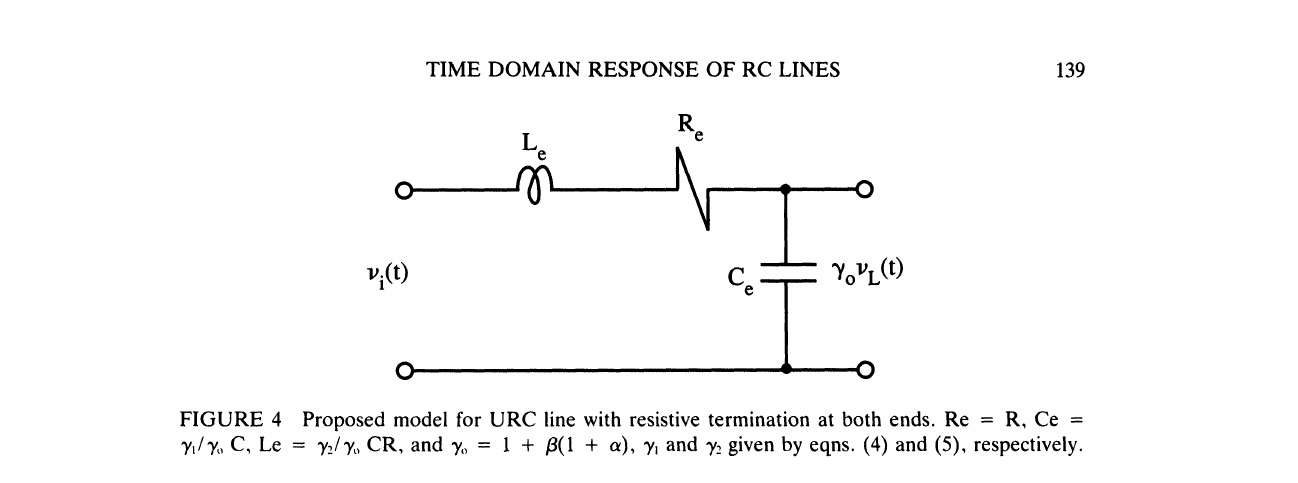
FIGURE 4 Proposed model for URC line with resistive termination at both ends. Re R, Ce "/t/y,, C, Le /2/% CR, and ,/,, + /3(1 + c), y and y. given by eqns. (4) and (5), respectively. obvious that the approximations of eqn. (3)-(5) accurately predict the performance of the URC line resistively terminated at both